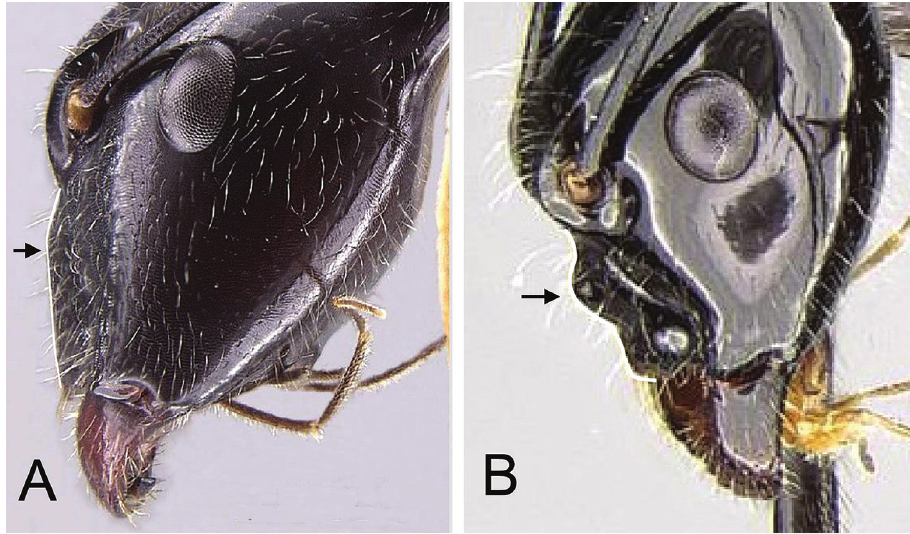
Figure 7. Head in lateral view showing the dorsal margin of the clypeus (similar in minor and major workers). A Camponotus longicollis (CASENT0191989) B Camponotus karaha (CASENT0353274).